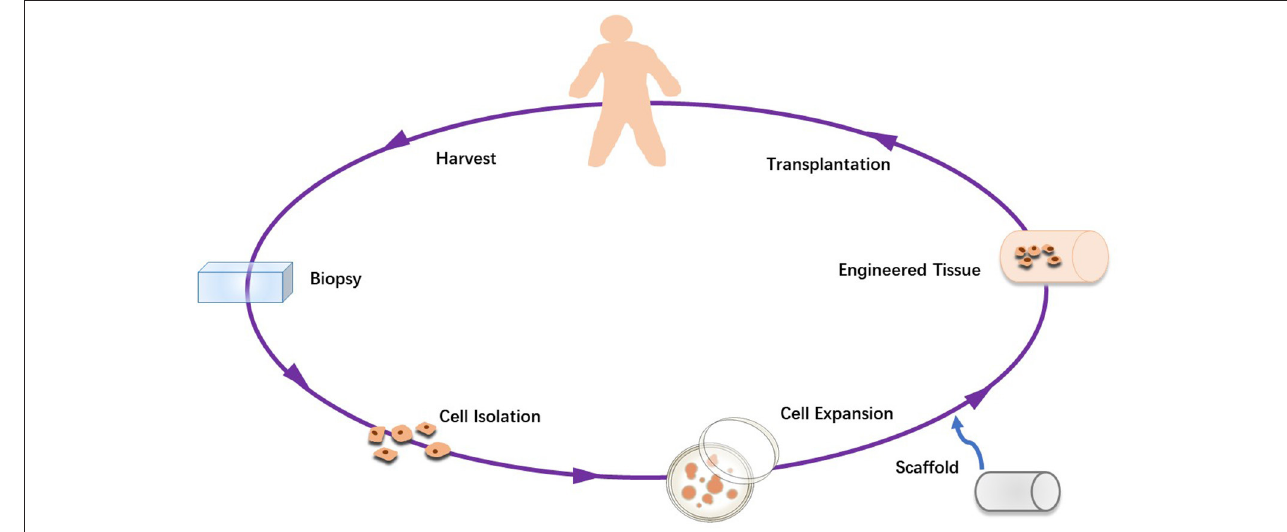
FIGURE 3 | Schematic diagram of tissue